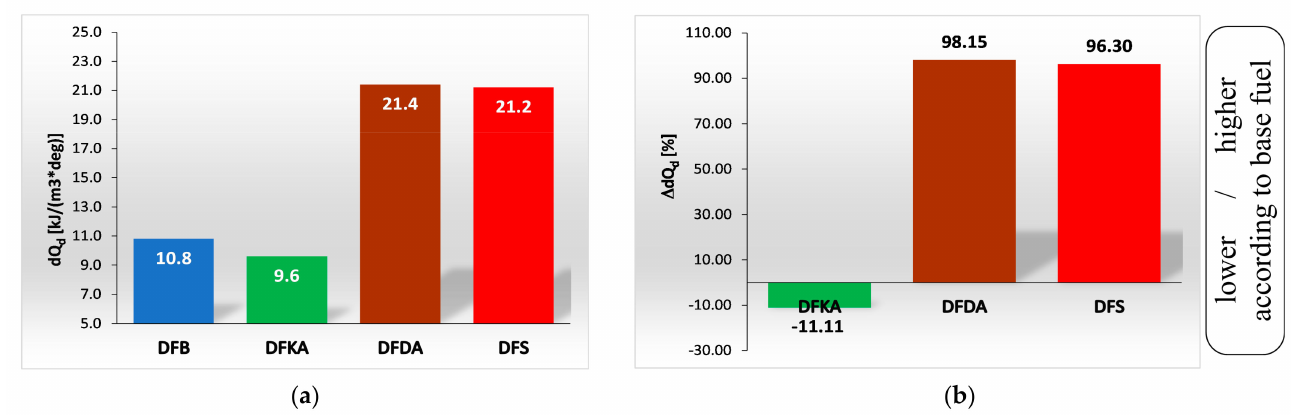
Figure 24. ( a ) Maximum rate of diffusion combustion (dQ d ) for tested fuels. ( b ) Percent change in maximum rate of diffusion combustion ( ∆ dQ d ) for tested fuels relative to dQ d for DFB (base